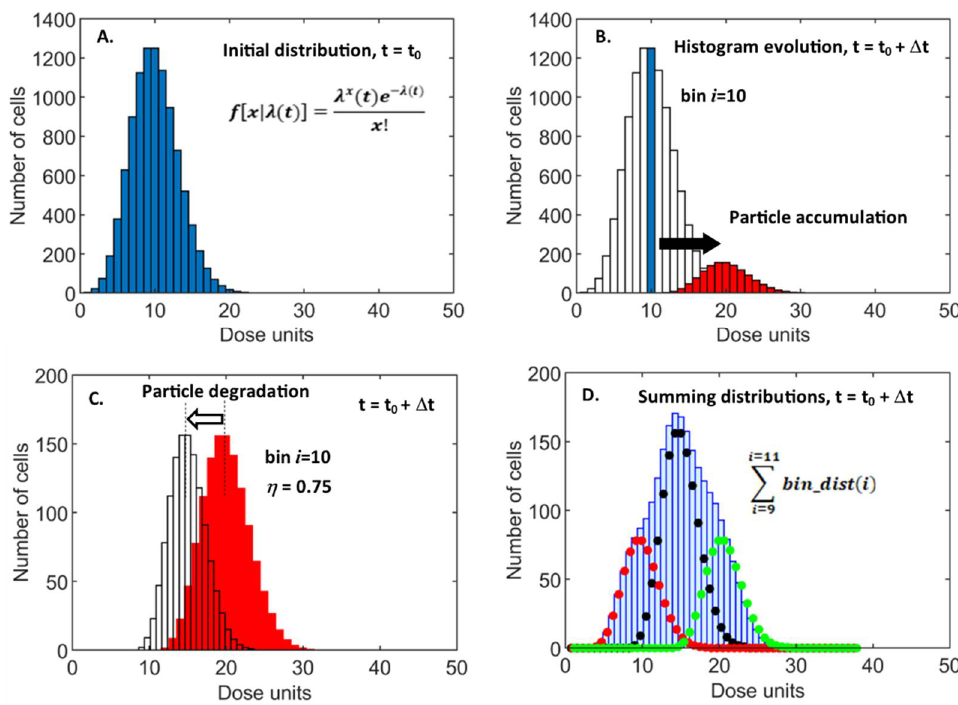
Figure 4. Schematic of histogram evolution to simulate particle accumulation and biodegradation. ( A ). Initial Poisson PDF generated at t 0 . ( B ). Continued NP accumulation within cells of bin 10 during t to t + Δt shown. ( C ). Reduction in dose by a fraction η, due to NP degradation. ( D ). final summing of dose at t + Δt. The example is shown for a limited sample of 3 distributions, corresponding to original bin indices 9, 10, and 11, at t 0 .